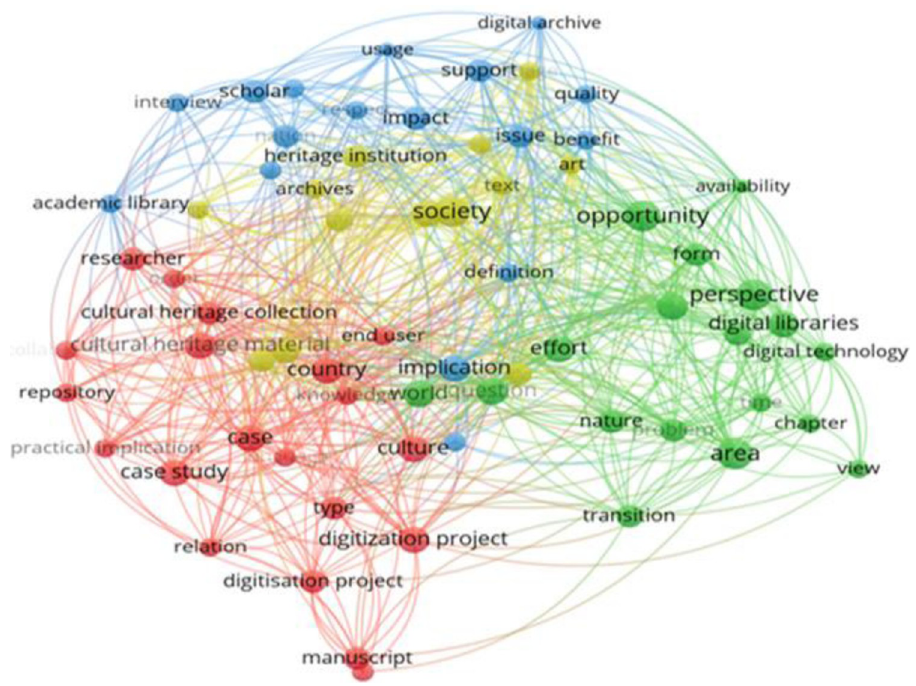
Fig 2. Keyword visualization